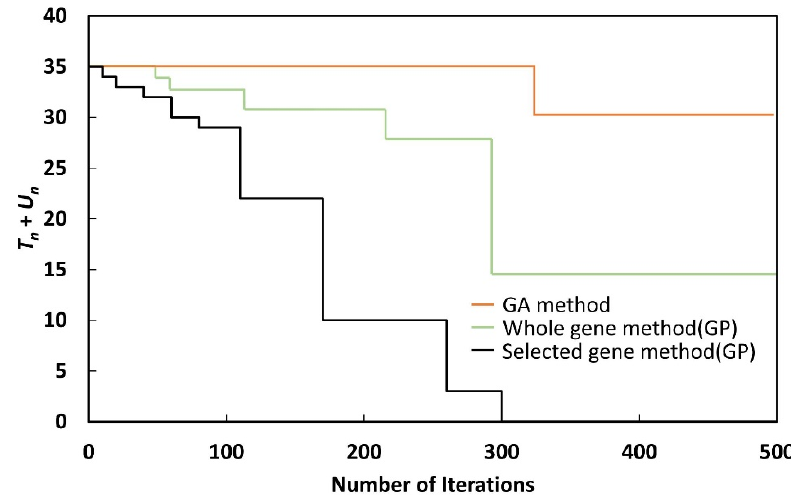
Figure 11. GP results for the minimized fitness function (2020).